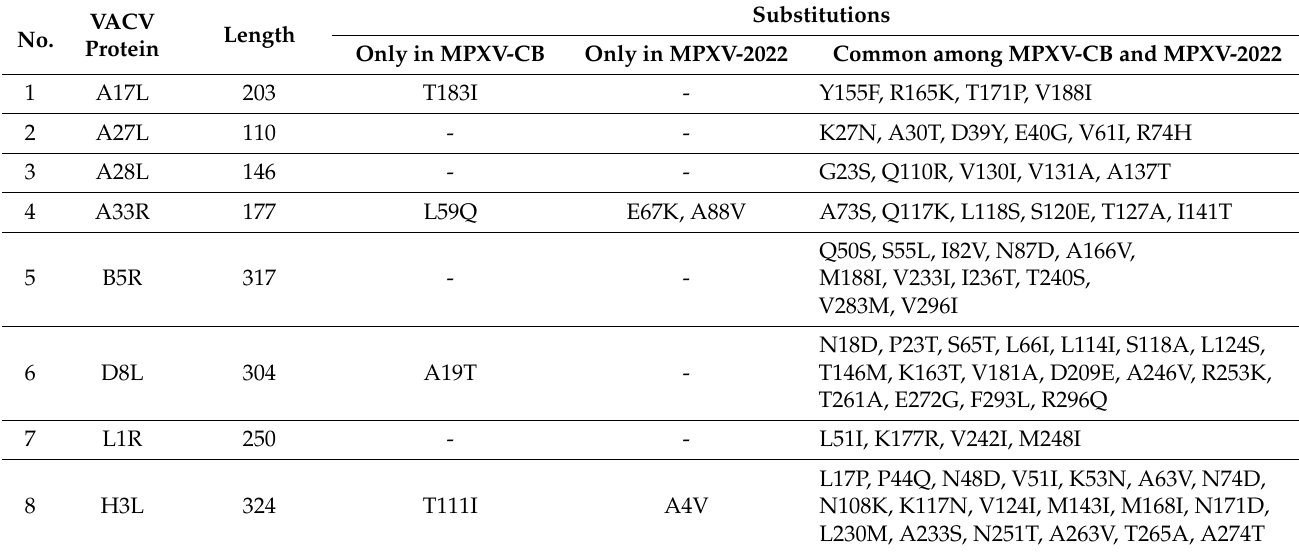
Table 2. Genetic comparison of known VACV NAb target proteins with corresponding proteins in MPXV-CB and MPXV-2022. The substitutions are computed with reference to the VACV proteins and using the consensus sequence of the ortholog protein for MPXV-2022.